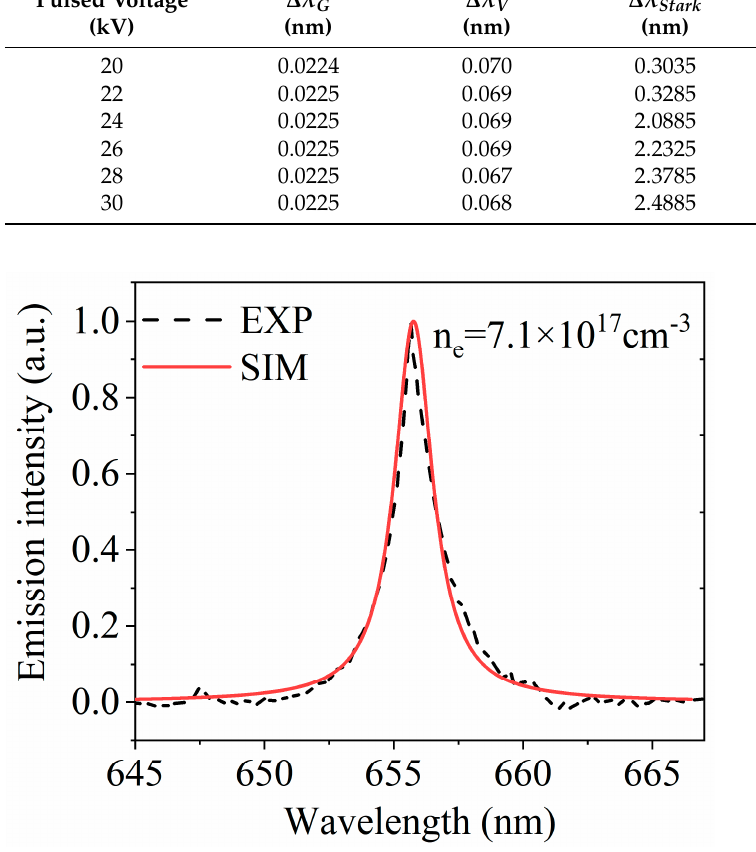
Figure 6. Comparison between the experimental and simulated results spectra of H α for calculating electron density. Table 2. The values of van der Waals broadening, Gaussian broadening, and Stark broadening of the H α line.